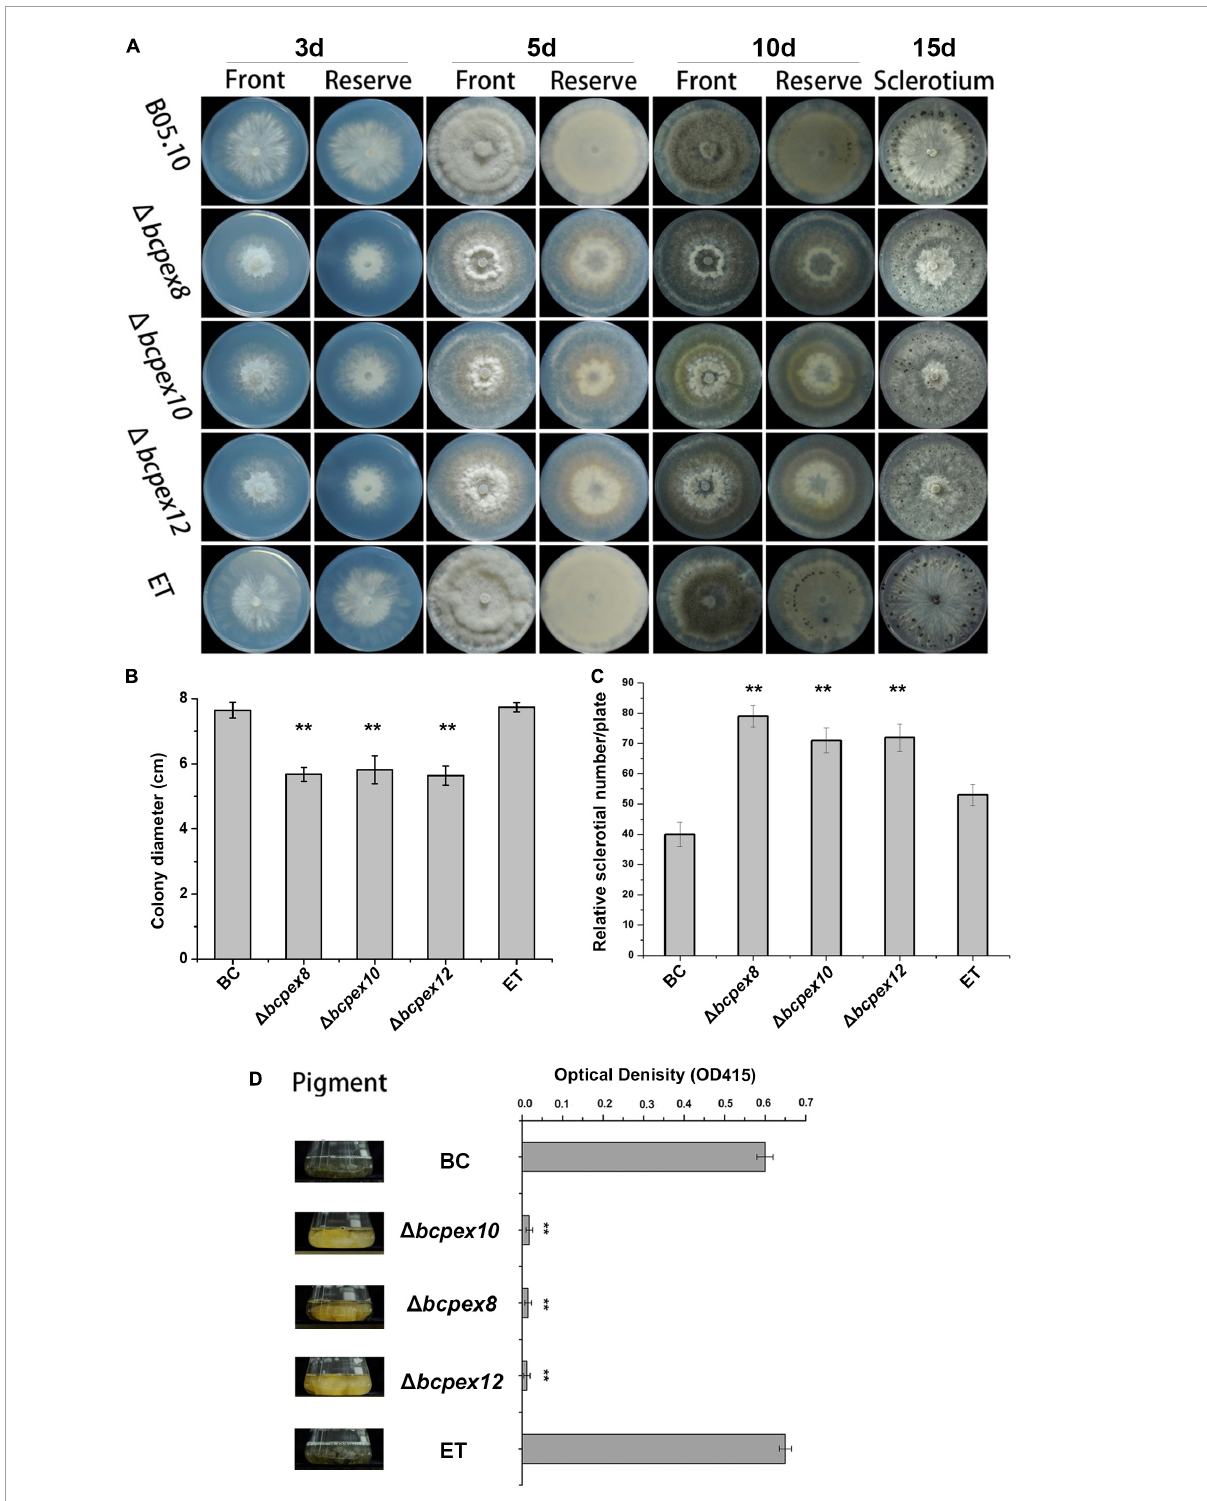
FIGURE3 Defects in lipid utilization in (cid:49) bcpex8 , (cid:49) bcpex10, and (cid:49) bcpex12 . (A) The mycelial growth of the (cid:49) bcpex8 , (cid:49) bcpex10 , (cid:49) bcpex12 mutants and WT and ET strains cultured on CM plate were measured at 3, 5, 10, and 15 days. (B) The colony diameters of the strains cultured on CM plate were measured at 3 days. (C) The sclerotium production of the strains cultured on CM plates was investigated at 15 days. (D) The melanin production of the strains was investigated by measuring the optical density of the sample at 415 nm (** p <